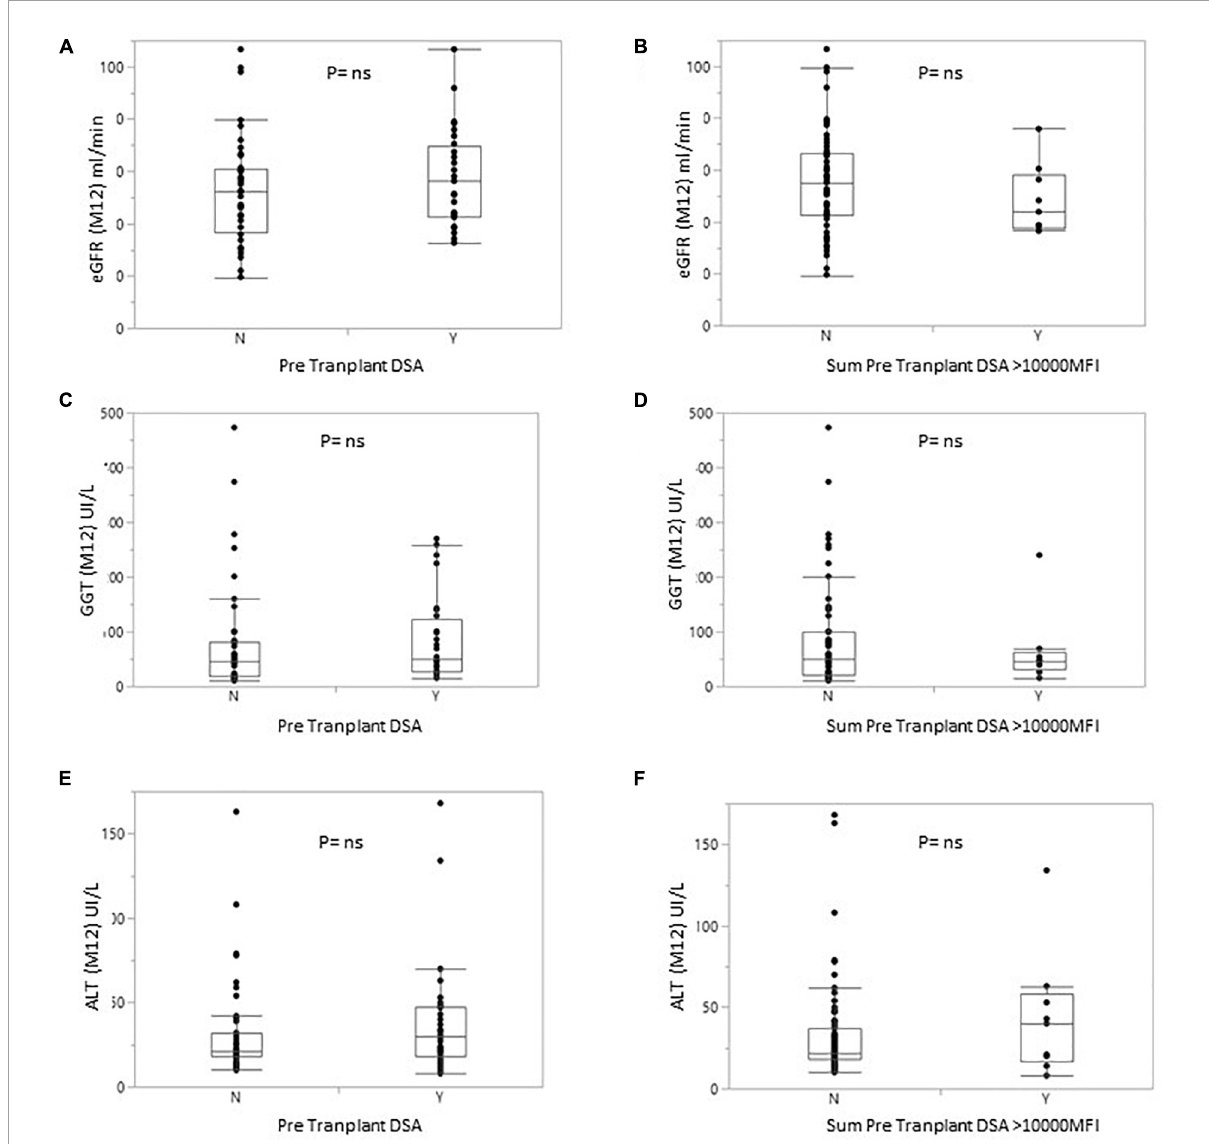
FIGURE4 Box plot of eGFR (A,B) or GGT (C,D) or alanine transaminase (E,F) levels for patients with or without pDSA (A,C,E) or with a highest pDSA with a MFI > 10,000 (B,D,F) . Y, yes; N,